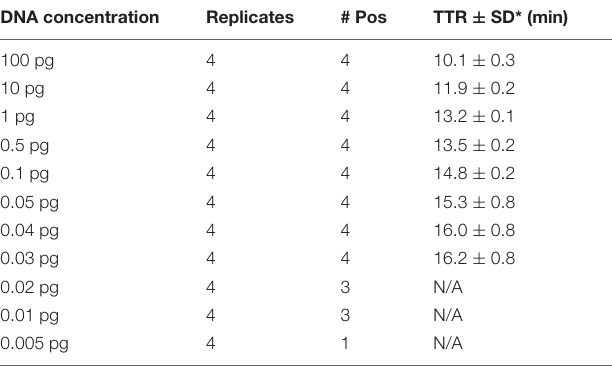
TABLE 5 | Time to result (mean of the TTRs of four replicates) for different concentrations of Y. pestis DNA. DNA